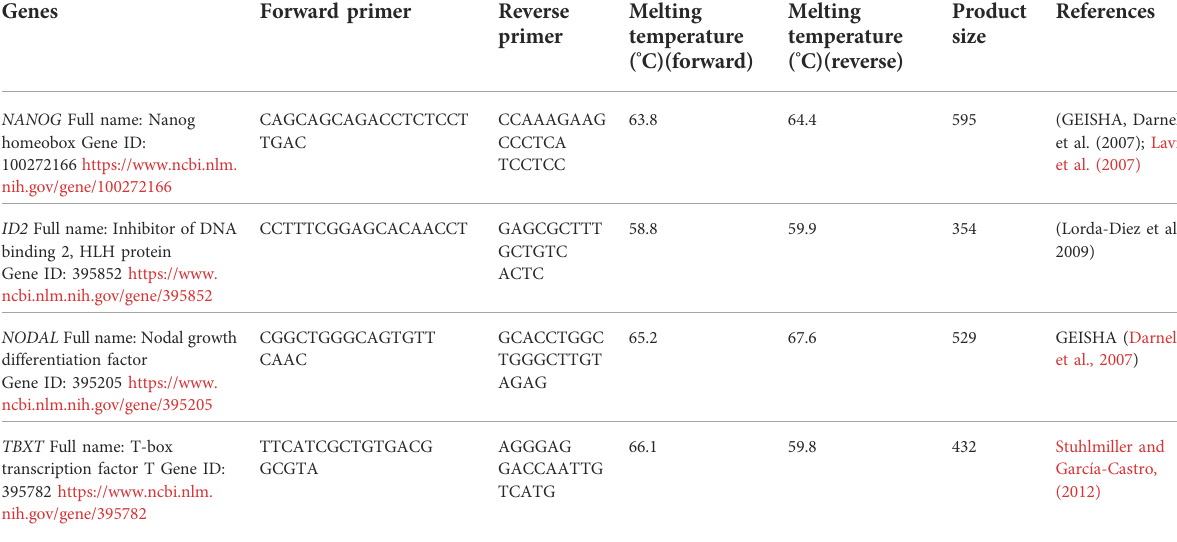
TABLE 1 List of primers used for making the template for the RNA